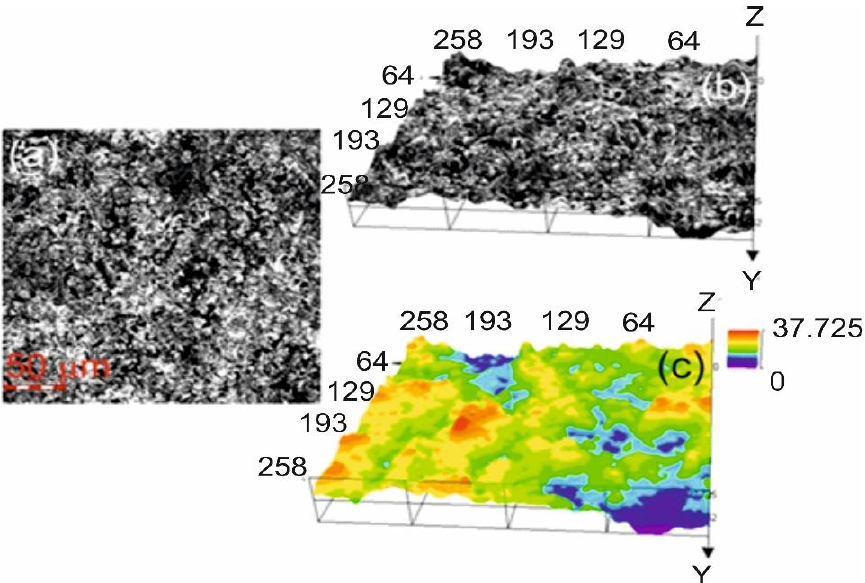
Figure 2. Surface texture of the (WC – Co + Cr) coating deposited on ductile cast iron created using a confocal microscopy; ( a ) 2D image; ( b ) 3D image; ( c ) 3D height mode.